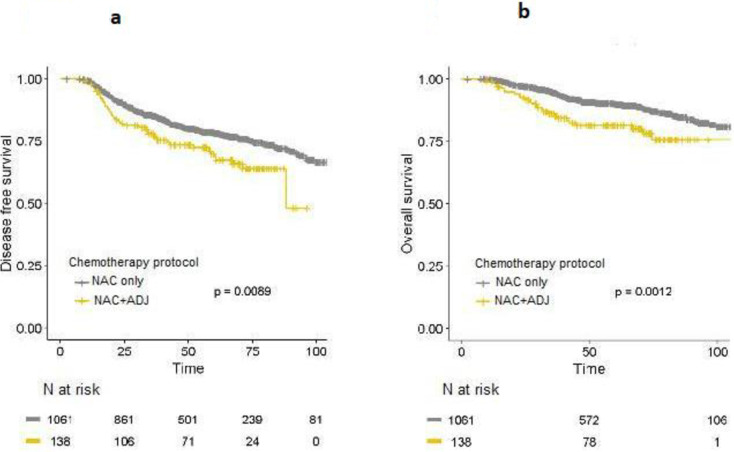
a-b. DFS (Fig 3a) and OS (Fig 3b) curves for whole population in the NAC only and NAC+ADJ groups, before PS matching.